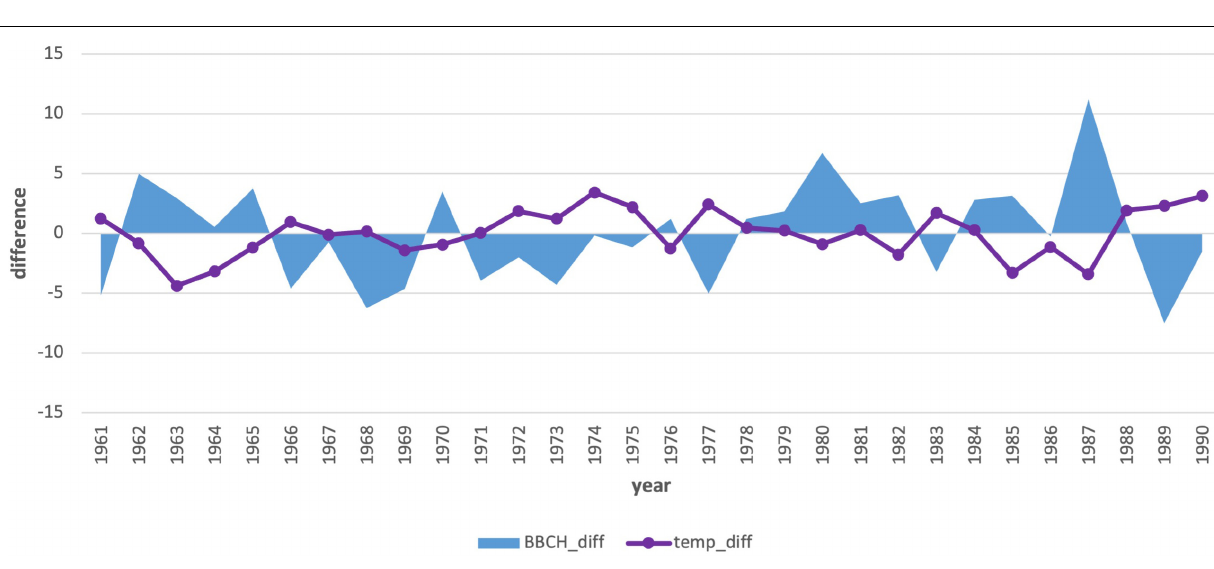
FIGURE 9 | Comparison of the average 3-month air temperature deviations from January to March with the deviations in the onset of the phenological phase from the long-term average from